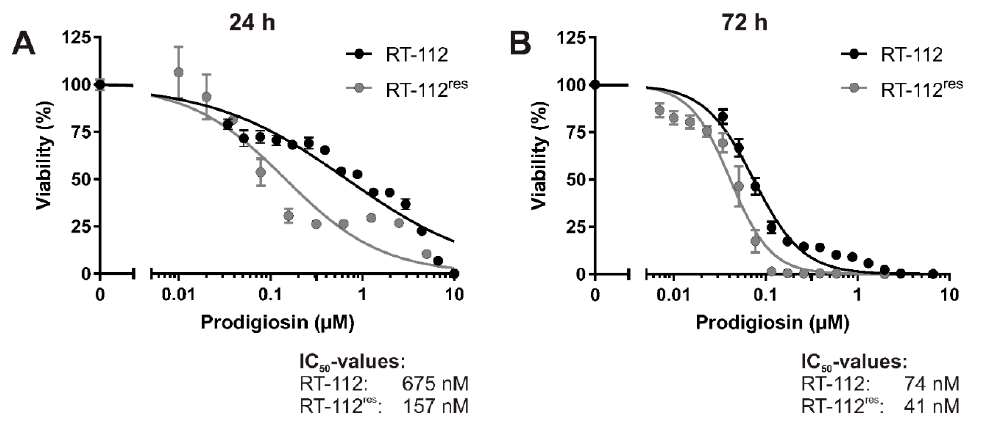
Figure 2. Prodigiosin is cytotoxic for cisplatin-sensitive and -resistant bladder carcinoma cells. RT-112 and RT-112 res cells were treated with different concentrations of prodigiosin for 24 h ( A ) or 72 h ( B ). After treatment, cell viability was measured using an thiazolyl blue (MTT) assay. Results are shown as the mean ± SEM of three independent experiments performed in triplicates for each